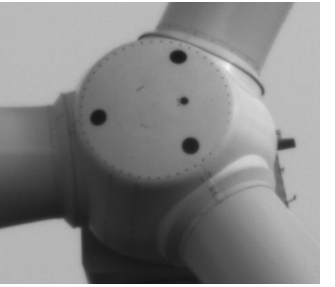
Figure 4. Three big dots on the nacelle for the application of marker tracking on the